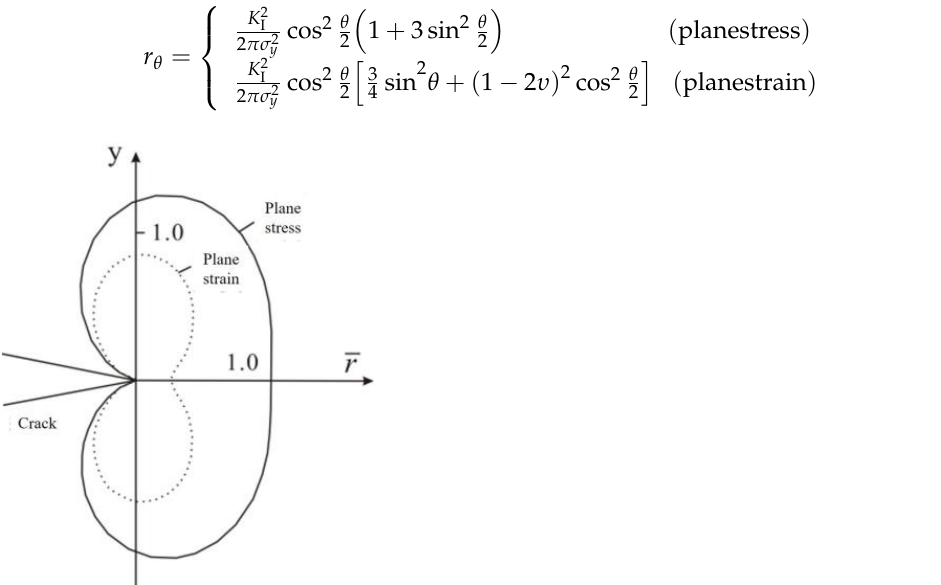
Figure 2. The shape and size of the process zone near the crack tip calculated theoretically [25].